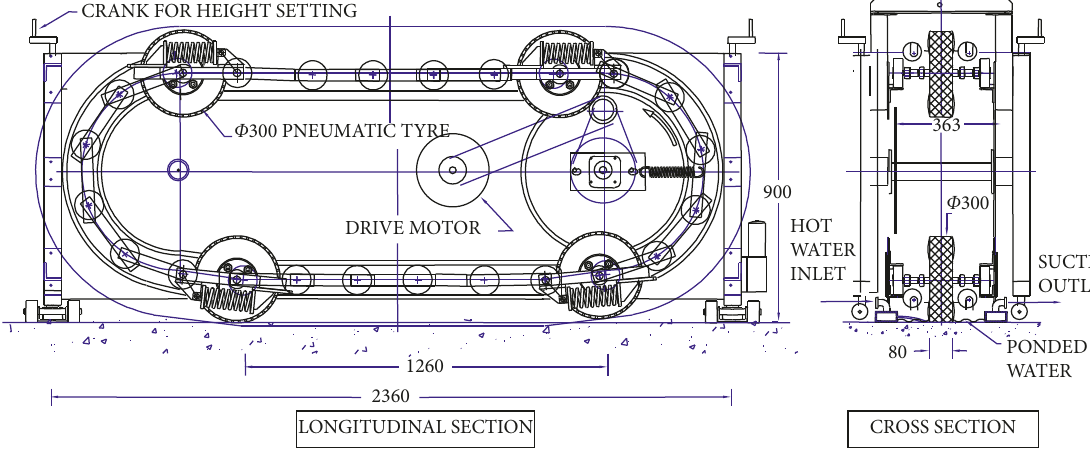
Figure 8: Schematic diagram of MMLS3.